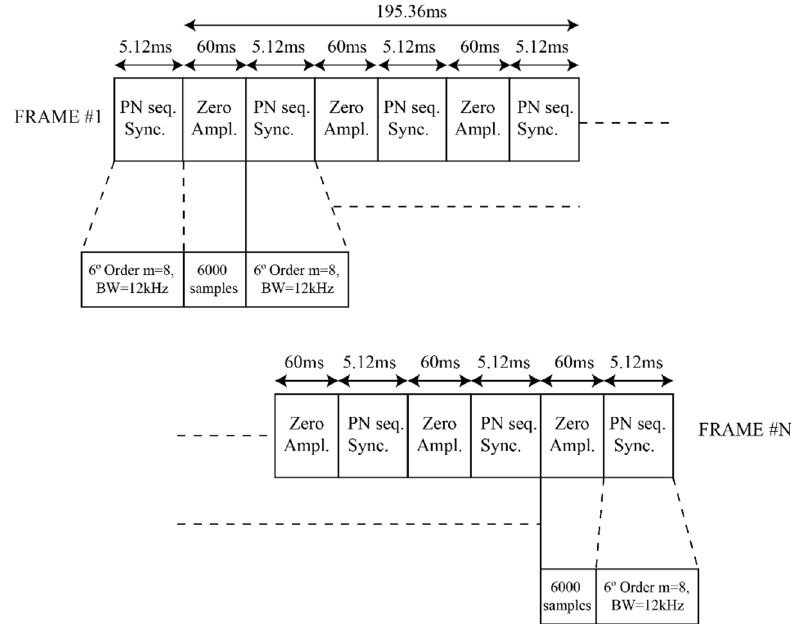
Figure 6. Second data frame design.